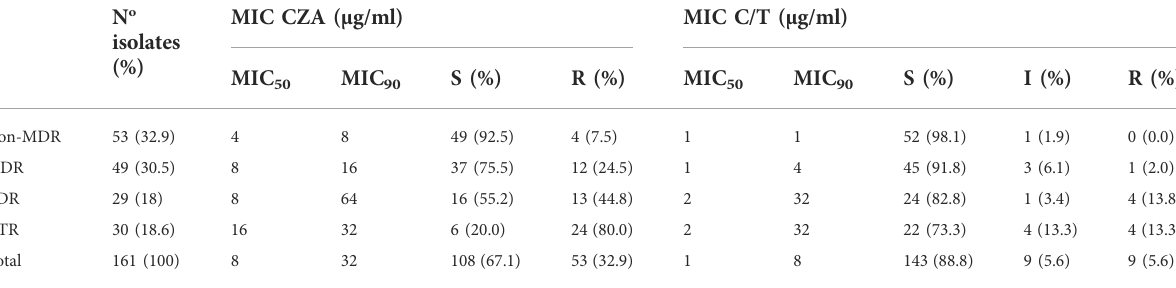
TABLE 2 CZA and C/T susceptibility pro fi le among Non-CP-CRPA clinical isolates with different multi-drug resistance